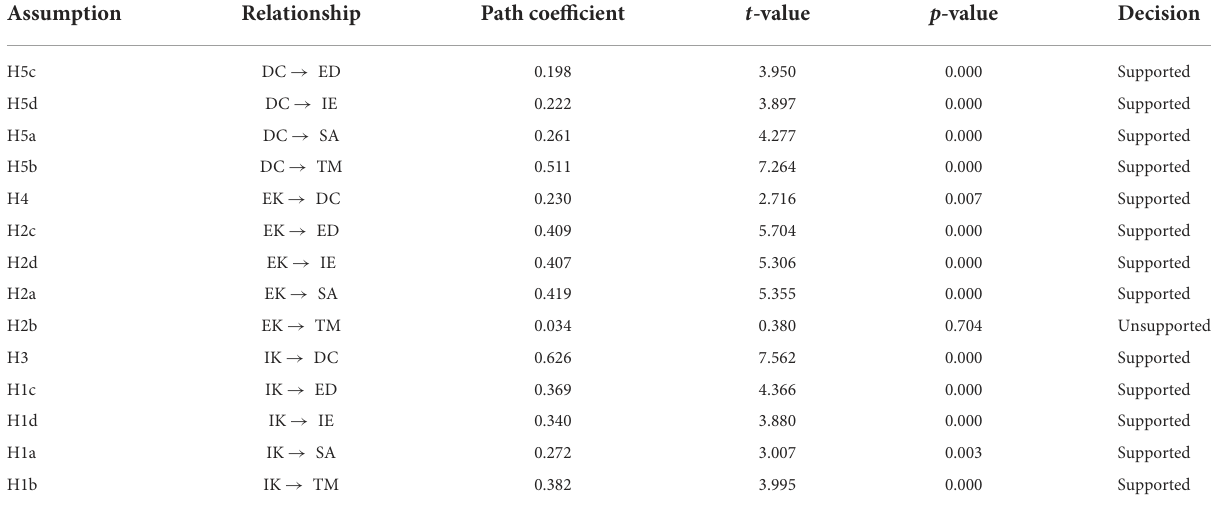
TABLE 7 Verification of direct effect path